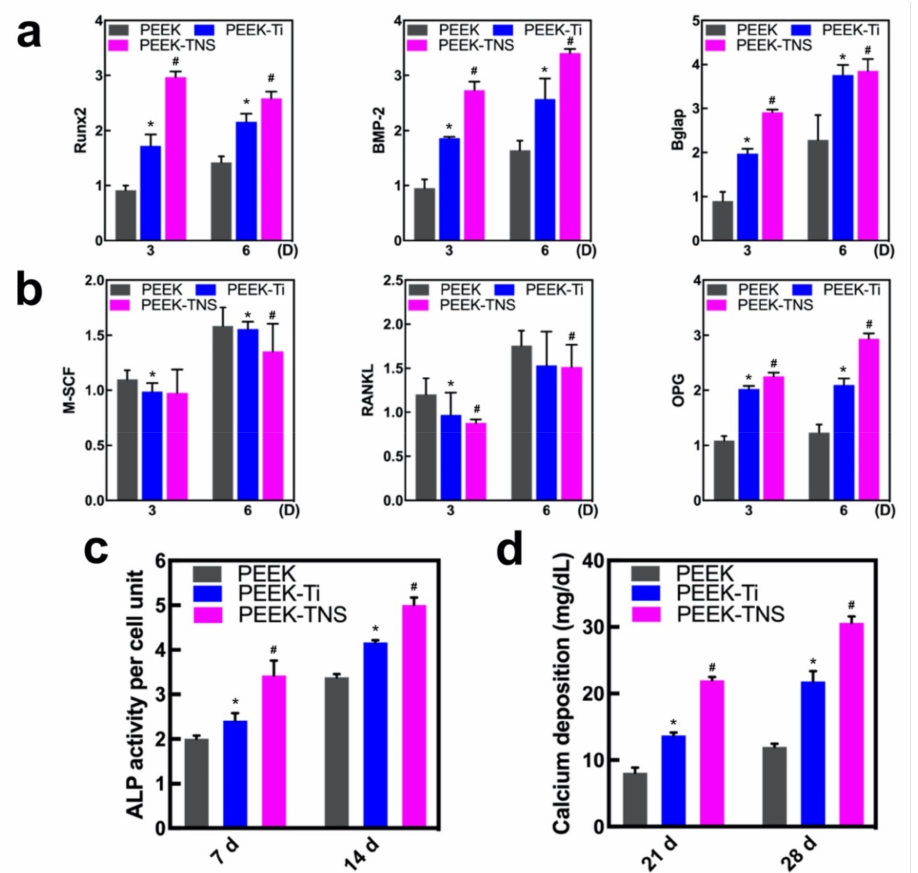
Figure 4. Osteogenic differentiation of rBMMSCs induced by macrophages on the PEEK, PEEK-Ti, and PEEK-TNS samples. ( a ) RT-qPCR of the osteogenic-related gene expressions. ( b ) RT-qPCR of the osteoclastogenesis-related gene expressions. ( c ) ALP activity levels of days 7 and 14. ( d ) Min- eralization levels of days 21 and 28. (* represents p < 0.05 when PEEK-Ti is compared with PEEK; # represents p < 0.05 when PEEK-TNS is compared with